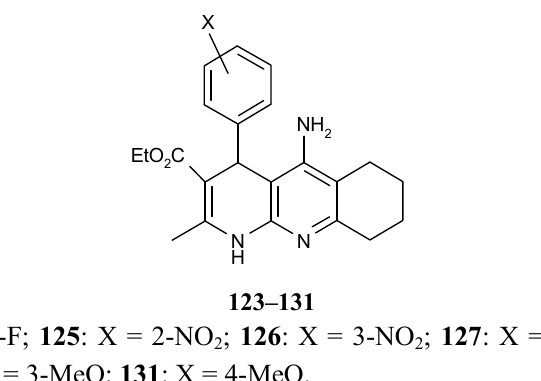
Figure 23. Tacrine-1,4-dihydropyridine hybrids 123–131